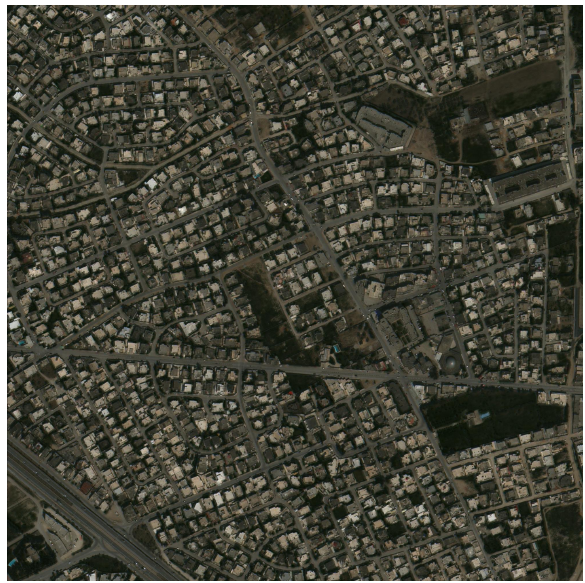
Figure 1: Top-Of-Atmosphere (TOA) reflections image showing a section 1 km × 1 km from a WorldView-2 triple-stereo-scene acquired 2011-04-13 over Tunis, channels 2, 3 and 5 (blue, green,